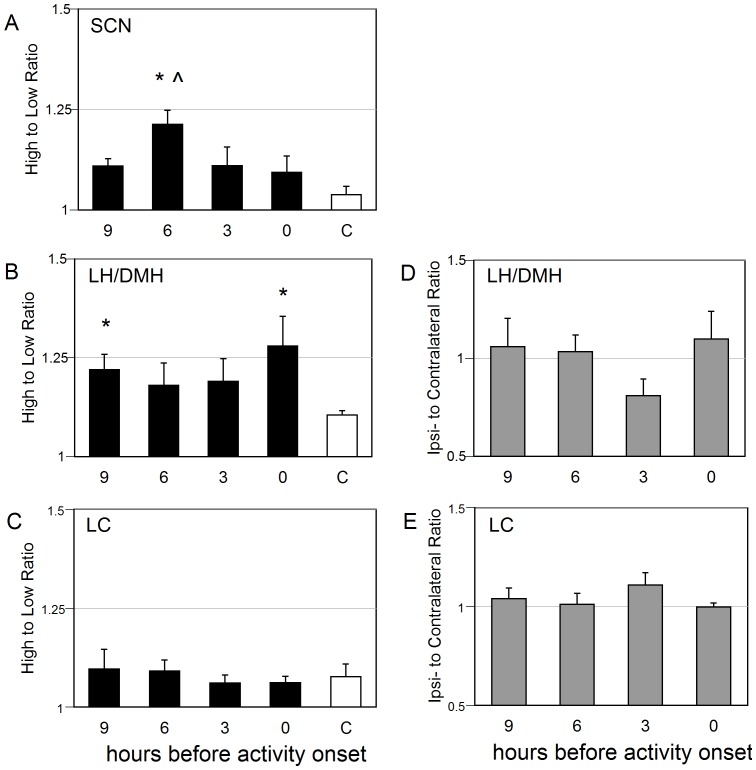
Asymmetry in the mean (±SEM) intensity of Per1 expression among hamsters maintained in LL in experiment 2.
Per1 expression was lateralized in cases in which the high to low ratio of Per1 expression exceeded that in non-split controls. The high to low ratio of Per1 expression is illustrated in the (A) AVP-expressing cells of the SCN, (B) HCRT-expressing cells of the LH/DMH and (C) TH-expressing cells of the LC. Consistency of lateralization to the high Per1 expressing SCN was assessed by the ipsilateral to contralateral ratios of Per1 expression in (D) HCRT-expressing cells of the LH/DMH and (E) TH-expressing cells of the LC. * p<0.05 vs. C; χ p<0.05 vs. 9 h before activity onset.